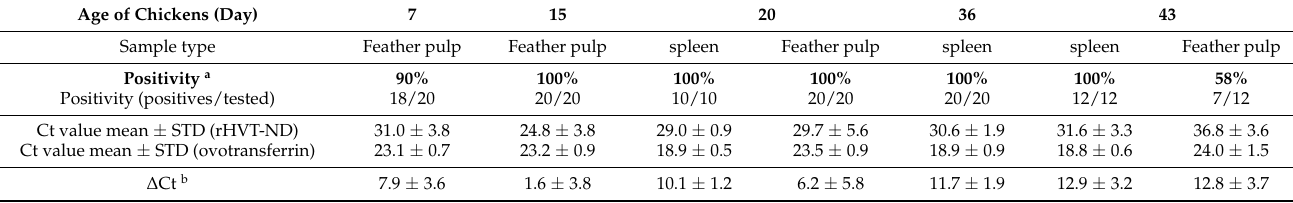
Table 2. Detection of vaccine-virus in feather tip pulps or spleen samples in the vaccinated group. Age of Chickens (Day)